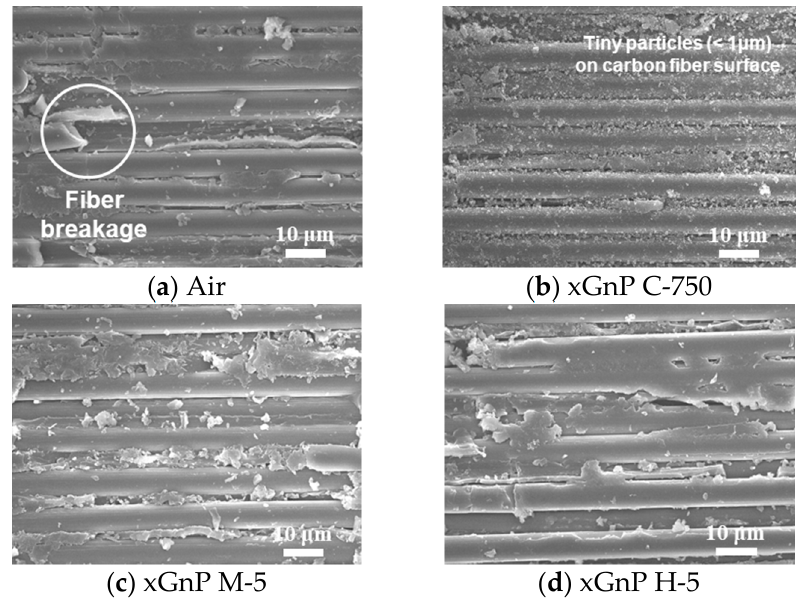
Figure 16. FE-SEM images of carbon fiber cutting angle of 0° (× 1400).